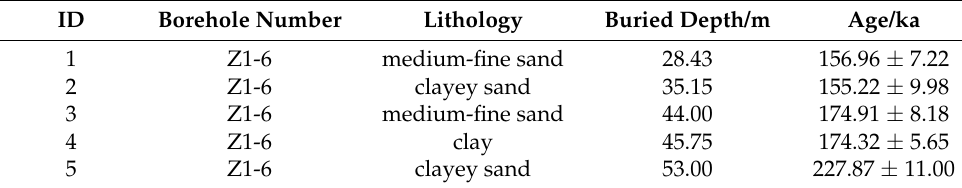
Table 3. The dating results of OSL samples in Xietan